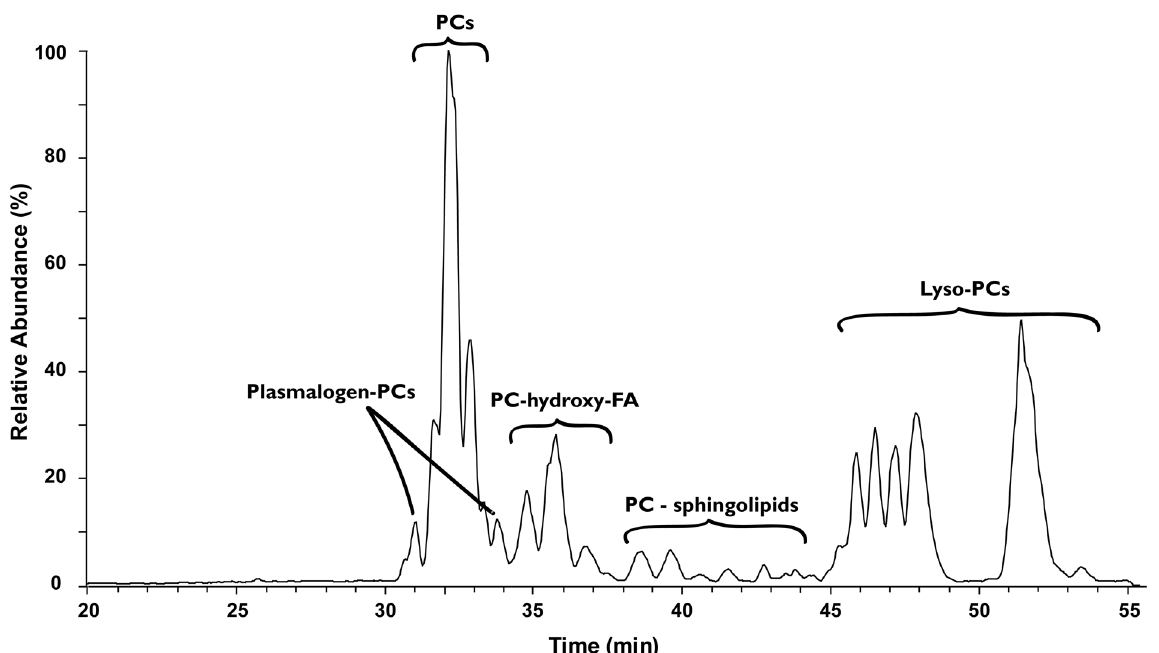
Fig 2. LC – MS chromatogram showing identified intact polar lipids in brown trout ( Salmo trutta ) gill tissue. Base peak LC – MS chromatogram (Gaussian smoothed) of MS 1 of intact polar lipids (IPLs) in brown trout ( Salmo trutta ) gill tissue showing the prevalence of the nitrogen-containing IPL phosphatidylcholine. PC = phosphatidylcholine.